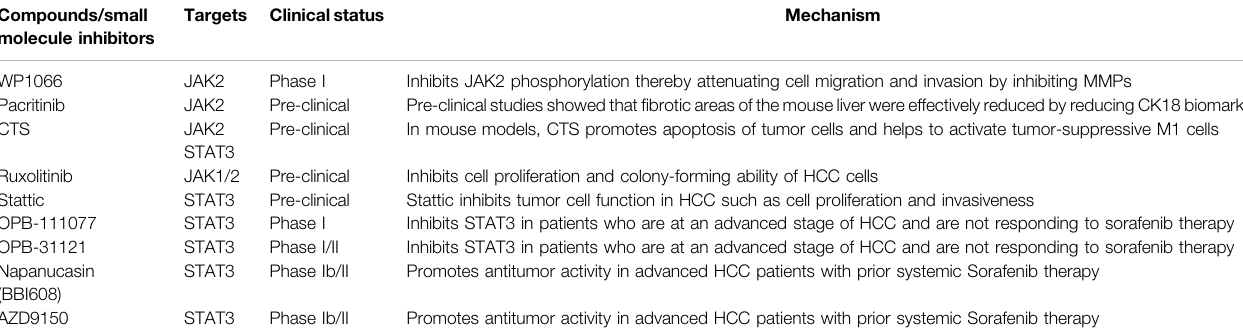
TABLE 4 | JAK/STAT signaling modulators, their targets, and mechanism in esophageal carcinoma/cells. Compounds/small molecule